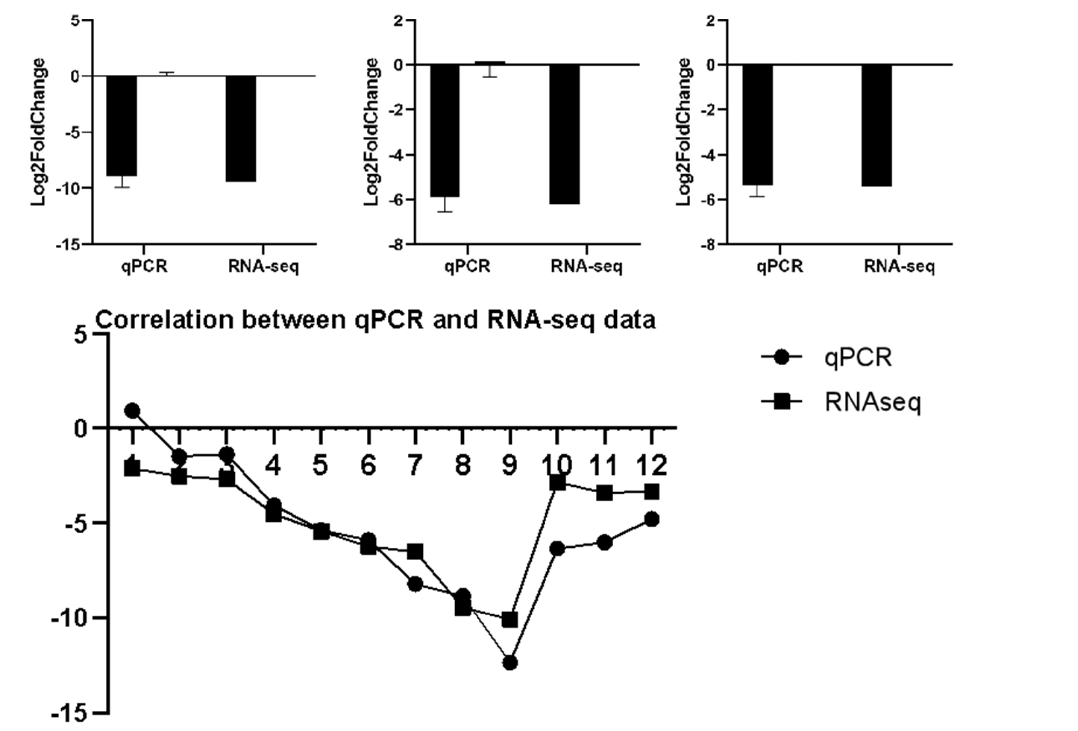
Figure 6. qRT-PCR verification of transcriptomic analysis results.